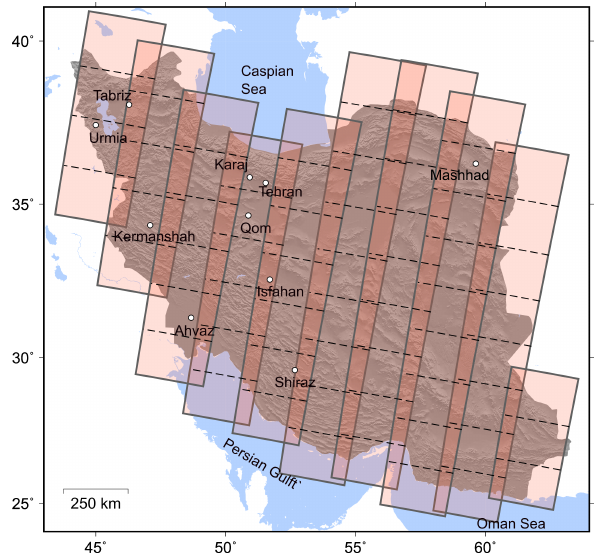
Figure 1. Coverage of Sentinel-1 frames in descending path in Iran overlaid on a shaded-relief map. Small circles indicate ten most populous cities of the country.